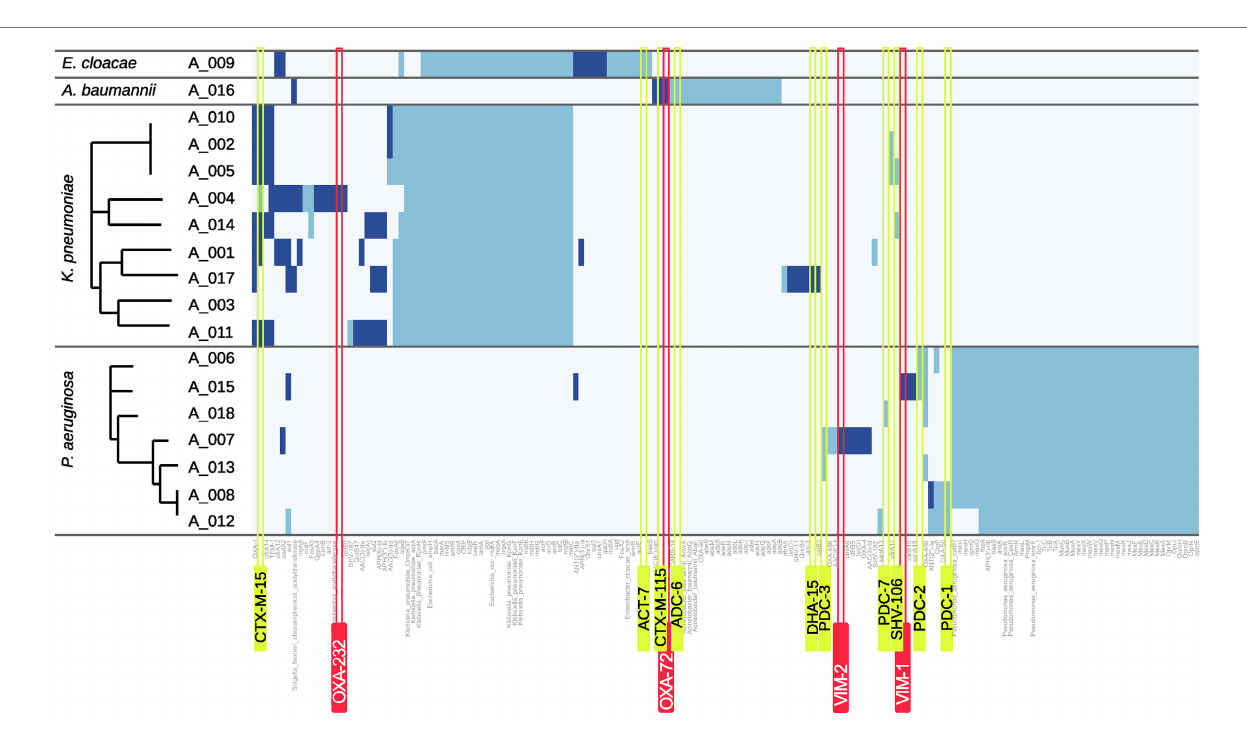
stop codon ( Figure 5 ). In addition, transposon insertions were found 15 bp upstream of ompK35 for two isolates, within ompK36 for two isolates, and within oprD for one